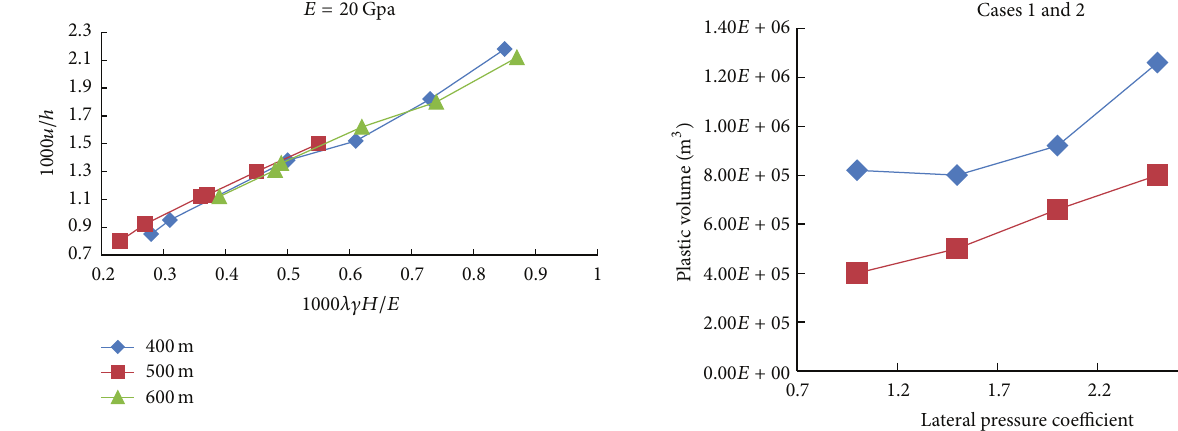
Figure 15: The relationship between 𝑢/ℎ and 𝜆𝛾𝐻/𝐸 ( 𝑑 = 0.18 and 𝐺 = 20 GPa).